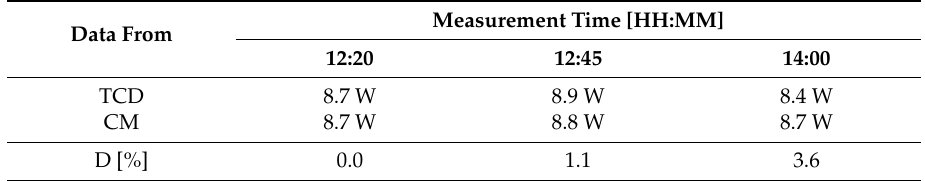
Table 8. Comparison of e ffi ciency in the whole system for the covered CPC system by experimental characterisation (TCD) and numerical simulation with relative discrepancy (CM) (17 July 2017). Data